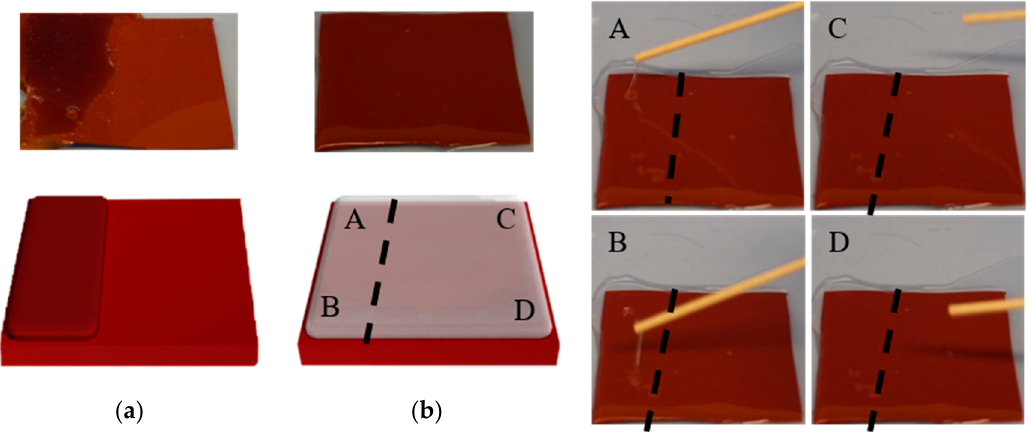
Figure 5. Experiment of PU on the fluorosilicone mold (the dash line represents the edge of PU, on the left of the line, PU is cured on and demolded from the mold). Left: ( a ) PU on the part of the mold, ( b ) Sylgard-184 on the whole mold after PU is demolded; Right: The photos after the applicator contacts to the different areas as in ( b ) .